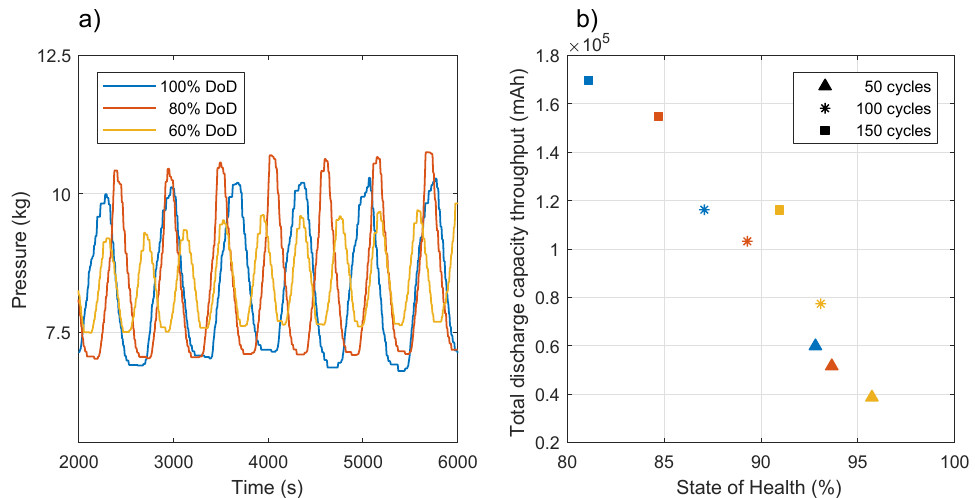
Figure 8. The effect of cycling DoD on ( a ) the cell’s generated perpendicular counterforce pressure due to volumetric constraints and ( b ) total discharge capacity throughput after 50, 100 and 150 cycles; the color legend in ( b ) is identical to ( a